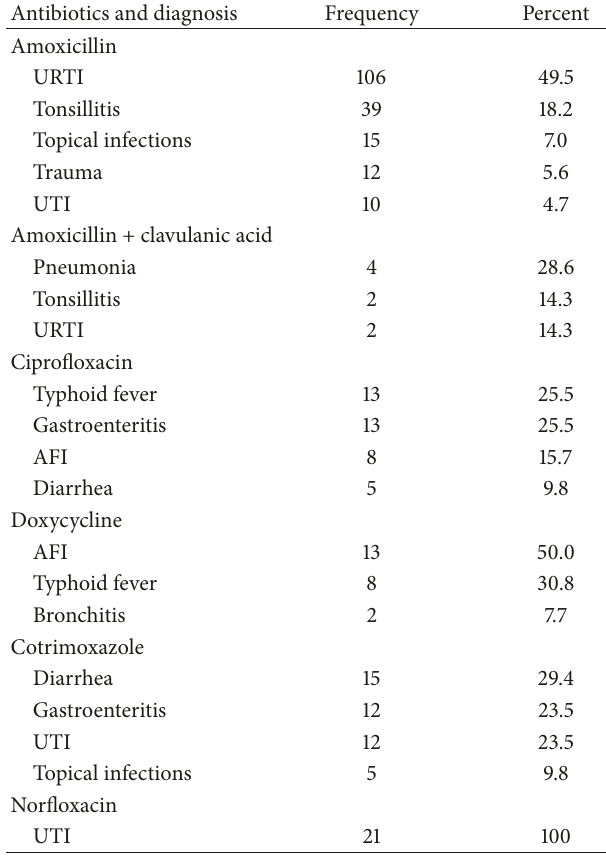
Table 4: Common diagnosis for frequently prescribed antibiotics (as a single medicine) at health centers in Addis Ababa,